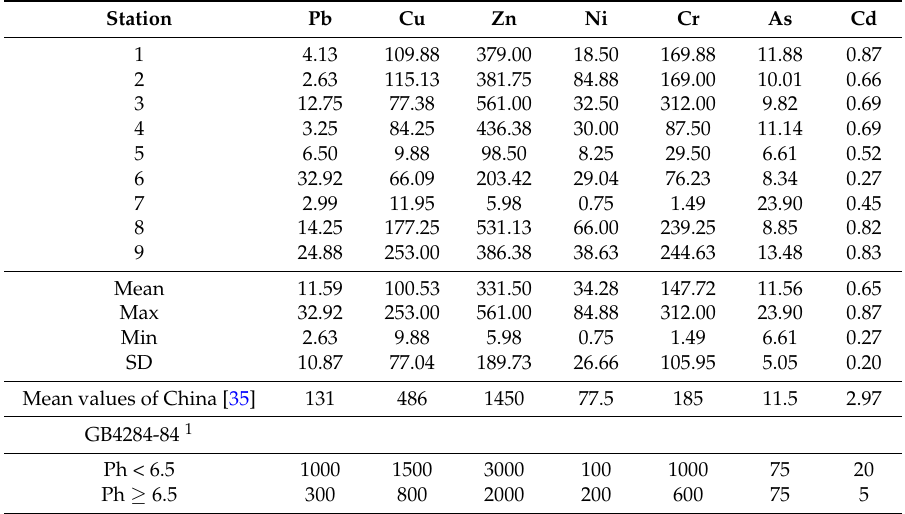
Table 2. Concentrations of heavy metals (mg/kg) in sewage sludge from 9 WWTPs. Station